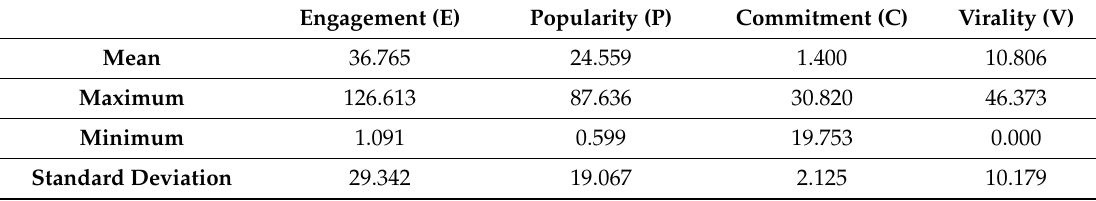
Table 5. Descriptive statistics of the engagement index, popularity, commitment and